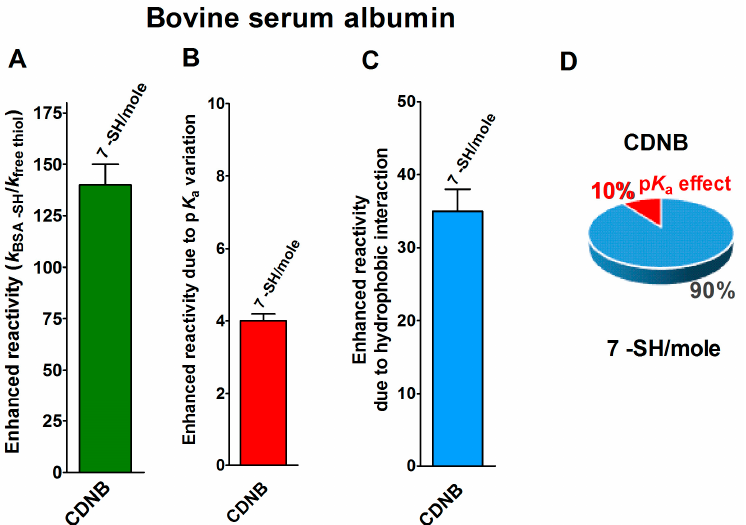
Figure 5. p K a and hydrophobic effects on the observed hyper-reactivity in the reduced bovine serum albumin. ( A ) Experimental kinetic data for the reaction of rBSA with CDNB at pH = 7.4, normalized to those of an unperturbed protein cysteine (enhanced reactivity) [14]. ( B ) Enhanced reactivity due to the experimental lower p K a for the seven most reactive cysteines (average p K a = 7.8). ( C ) Enhanced reactivity due to hydrophobic interaction. ( D ) The circle diagram shows the percent contribution of the two factors: the hydrophobic effect (blue) and the p K a effect (red). The 100% represents the sum of the values reported in panels ( B ) and ( C ). The error bars in panels ( A – C ) are derived from the propagation of uncertainties (see Section 4).